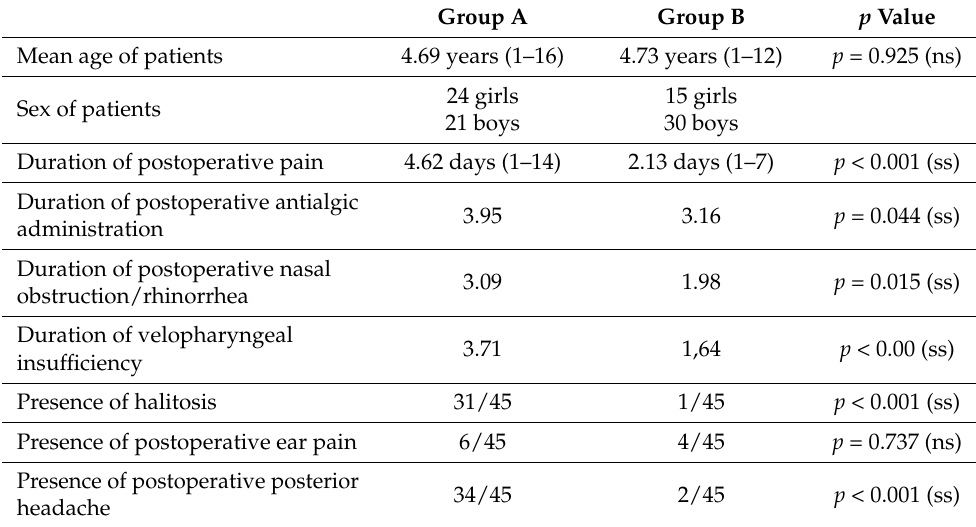
Table 1. Structure of two groups, variables studied, and their statistical significance: ss—statistically significant ( p < 0.05), ns—not